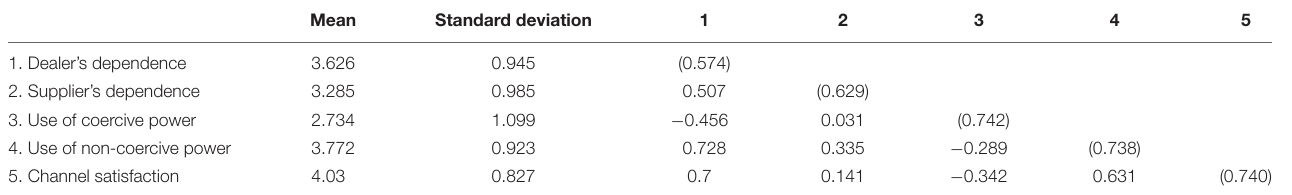
TABLE 2 | Mean, standard deviation, correlation coefficient, and AVE values of relevant variables in this